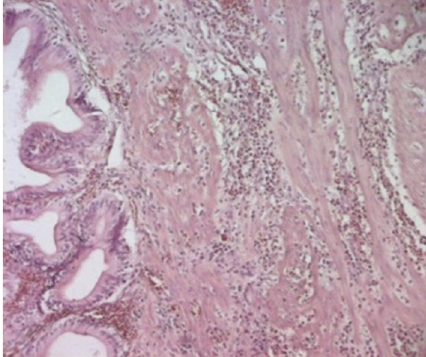
Figure 4: Inflammatory infiltrate consisted predominantly of eos- inophils, suggesting eosinophilic